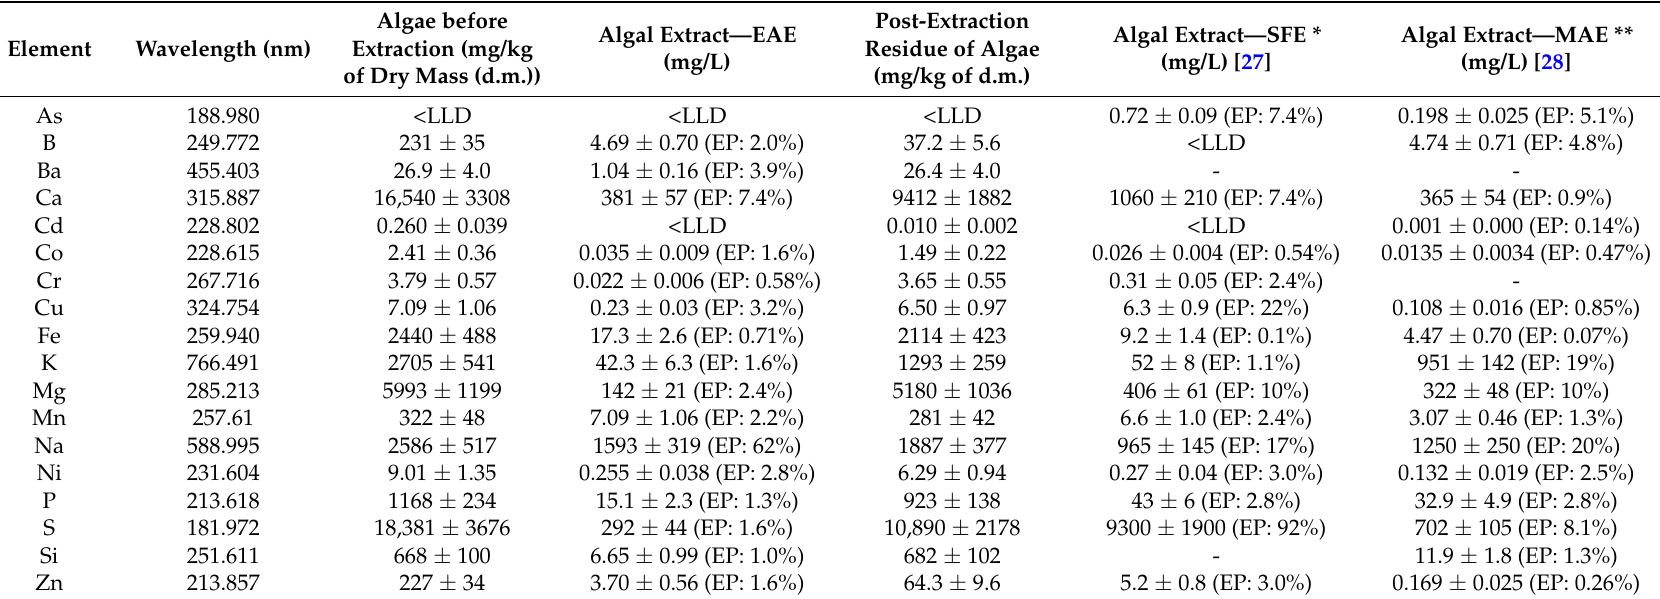
Table 2. The multielemental composition of raw algal biomass, algal extract obtained by the enzyme-assisted extraction and post-extraction residue ( n = 3).